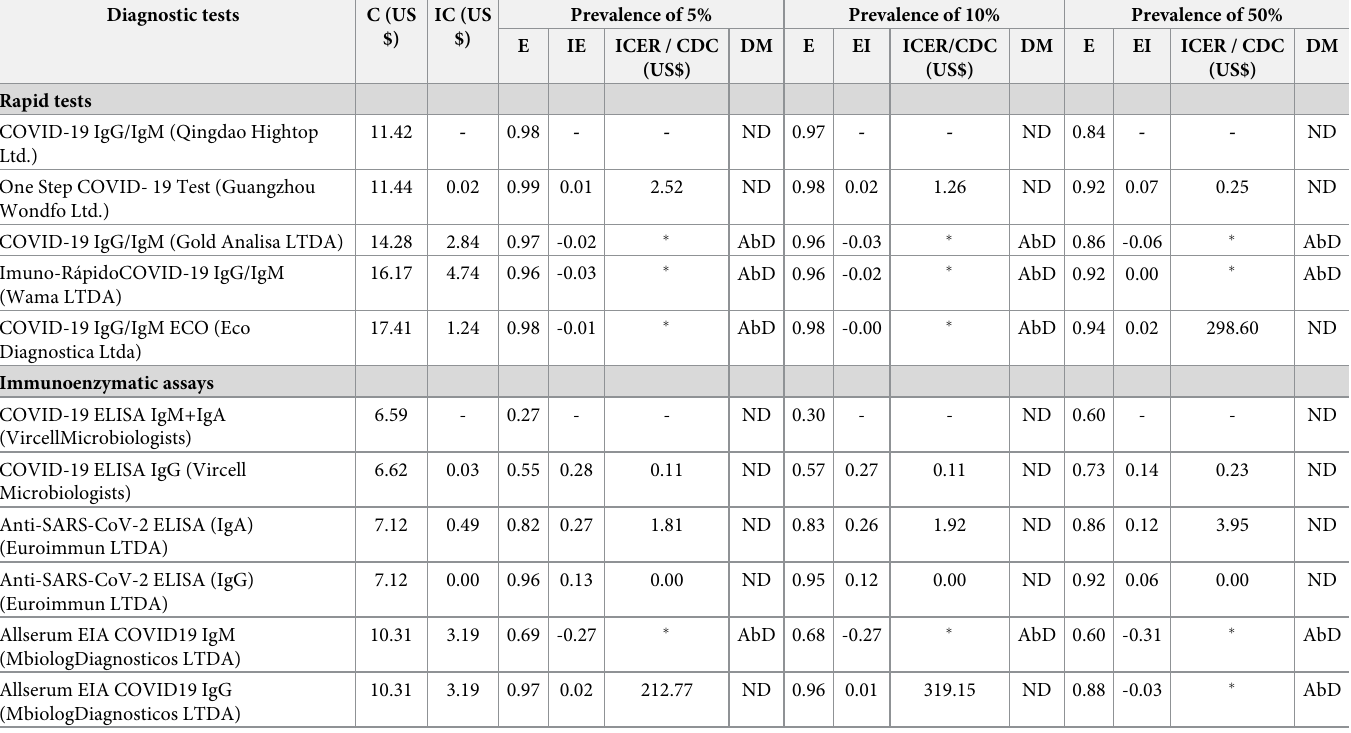
Table 4. Cost-effectiveness analysis of rapid tests and immunoenzymatic assays for three pretest probability scenarios of 5%, 10%, and 50%. Diagnostic